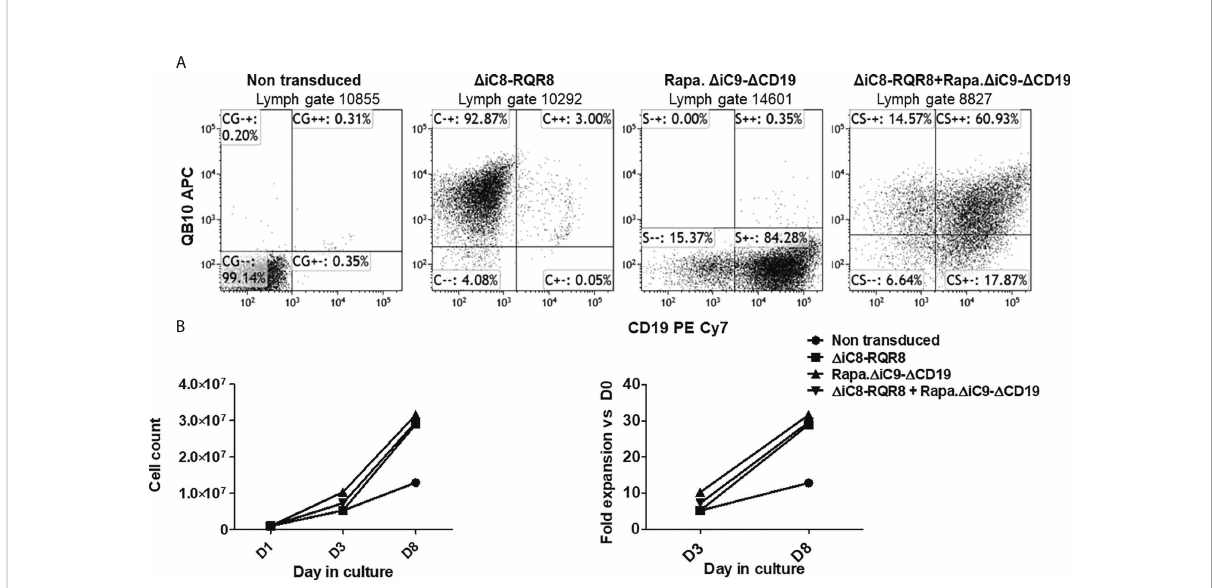
FIGURE 2 (A) Representative fl ow cytometry expression of the selectable marker for Jurkat non-transduced or gene-modi fi ed with ( F36V). D iC8-RQR8 , Rapa. D iC9- D CD19 or co-transduced. (B) (left) Average with SD of cell count and (right) fold expansion of non-transduced or suicide gene- modi fi ed cells (one experiment in